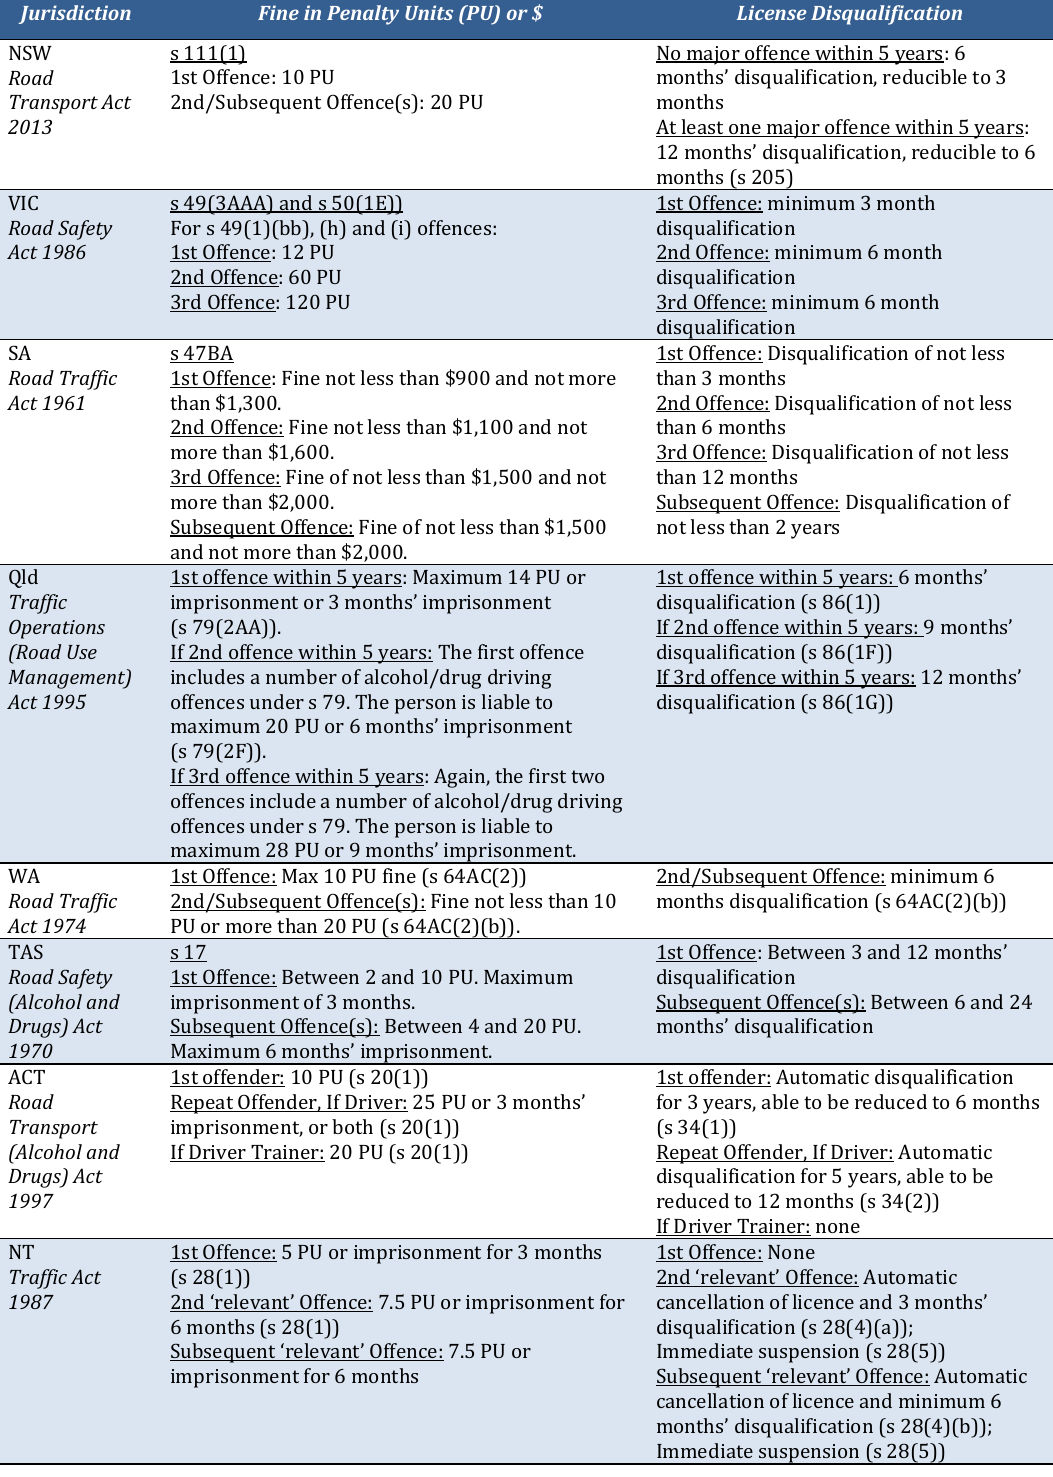
Table 2: Penalties for ‘presence’ drug driving offences in Australia Jurisdiction Fine in Penalty Units (PU) or $ License